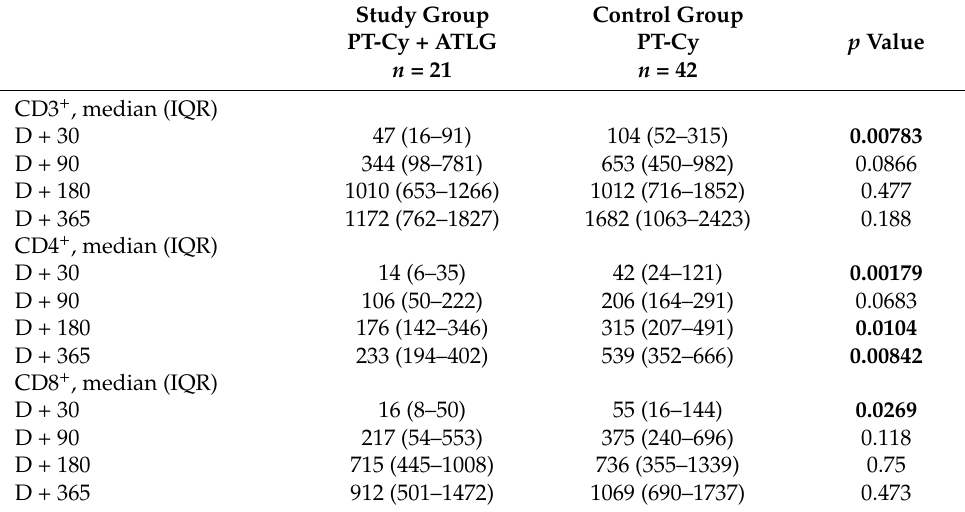
Table 2. T cell immune